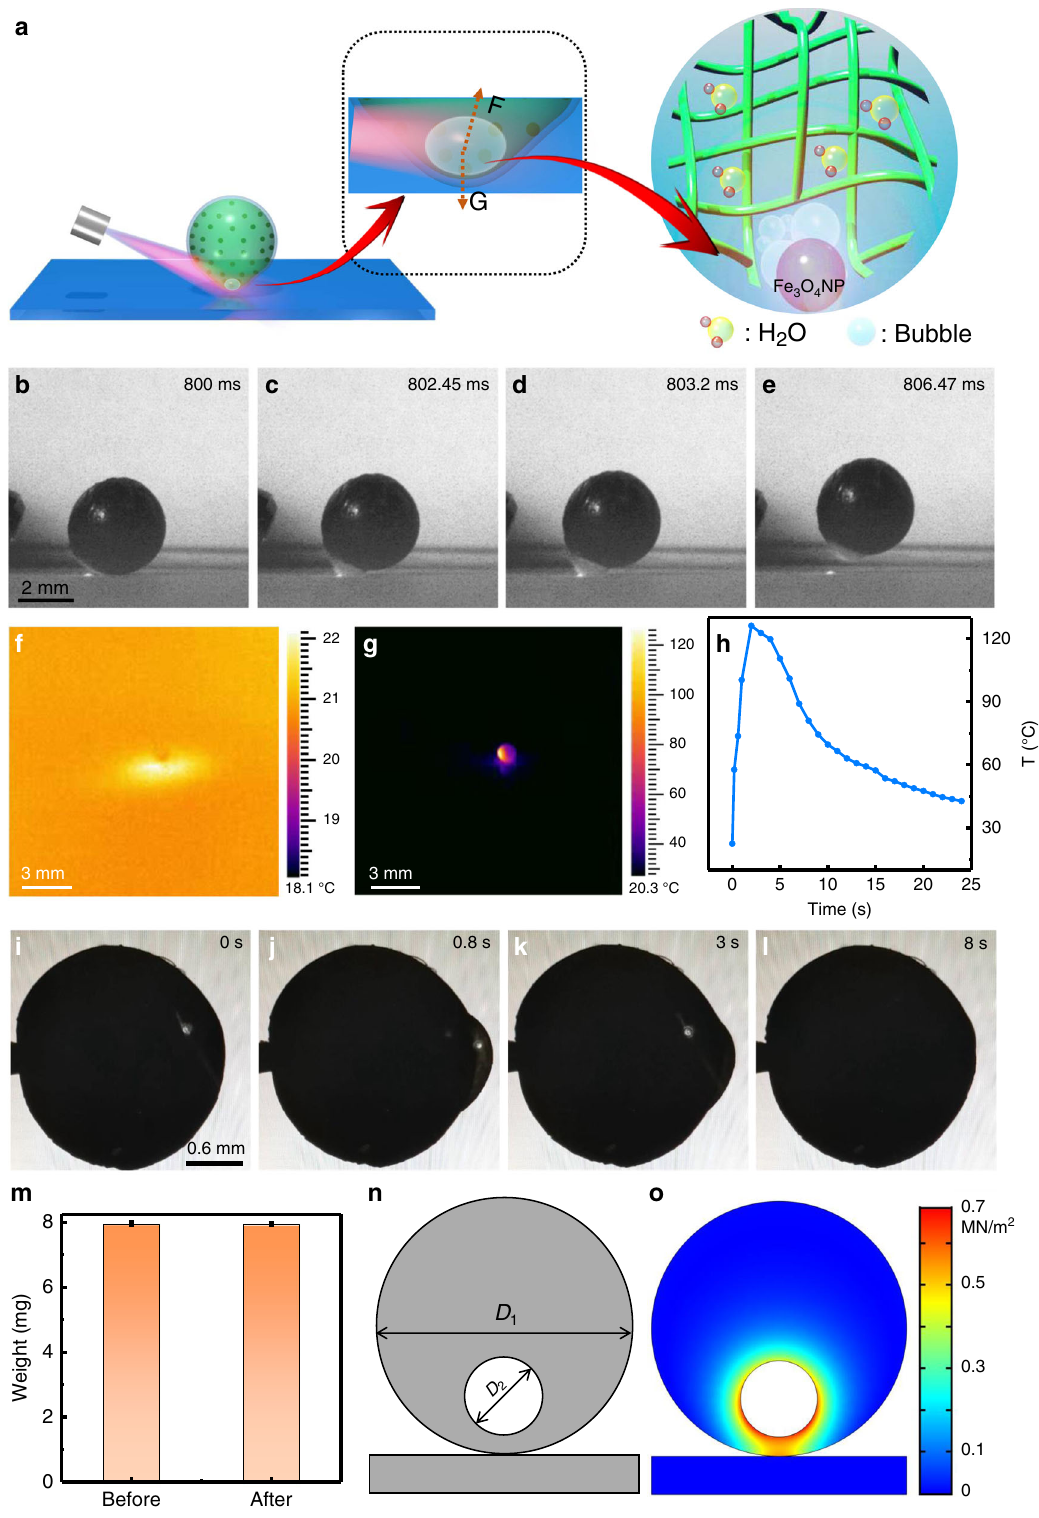
Fig. 2 Motion mechanism of the hydrogel actuator. a Schematic illustrates the local shape change of the hydrogel actuator caused by the photothermal effect of IONP and the thereafter water vaporization under light irradiation. b – e A series of high-speed camera images obtained from Supplementary Video 3 showing the take-off process of the hydrogel actuator under light irradiation (2.34 W) at the bottom part of the hydrogel actuator. Infrared thermal images of the hydrogel actuator f before and g after light irradiation. h The temperature change during the jumping process. i – l A series of CCD images indicating the shape deformation and recovery at the irradiated area of the hydrogel actuator fi xed at a needle end. m The weight of the hydrogel actuator before and after jumping. n – o The force analysis of the jumping behavior of the hydrogel actuator by using the numerical simulations. Error bars denote the standard